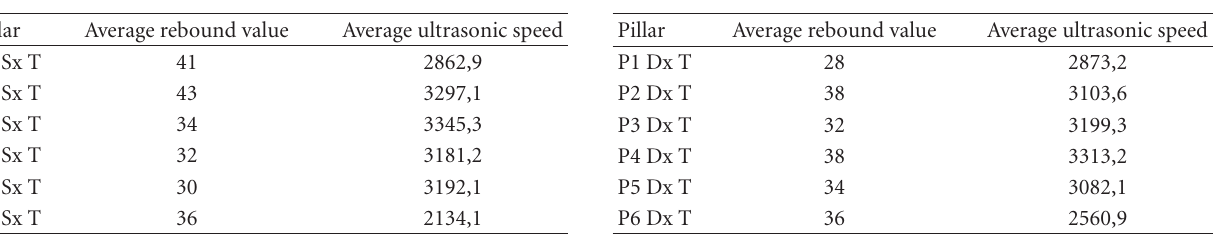
Table 3: Left side pillar (Sx): Ground floor. Table 4: Right side pillar (Dx): Ground